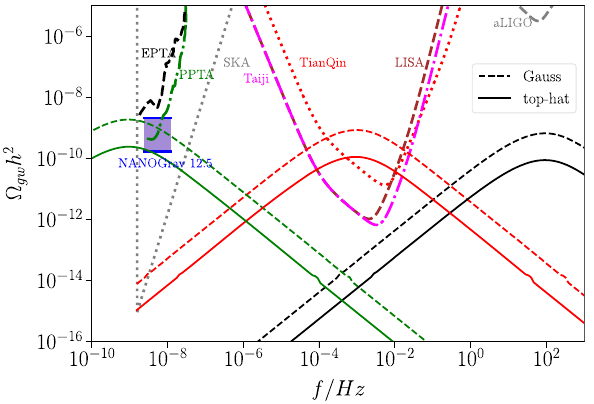
The light green shaded region is excluded by the CMB observations [134]. The cyan, orange and blue regions show the constraints from the EPTA observations [151], the effect on the ratio between neutron and proton during the big bang nucleosynthesis (BBN) [152] and μ - distortion of CMB [153], respectively. The red and black bands are from the left panel PBHs observational data. The black curve in the right panel is the parameterization (32) with the best parameter values (33) and (34) obtained from the Bayesian analysis of PTA data, and the black curve in the left panel is the corresponding mass function calculated by the peak theory with the Gaussian window function